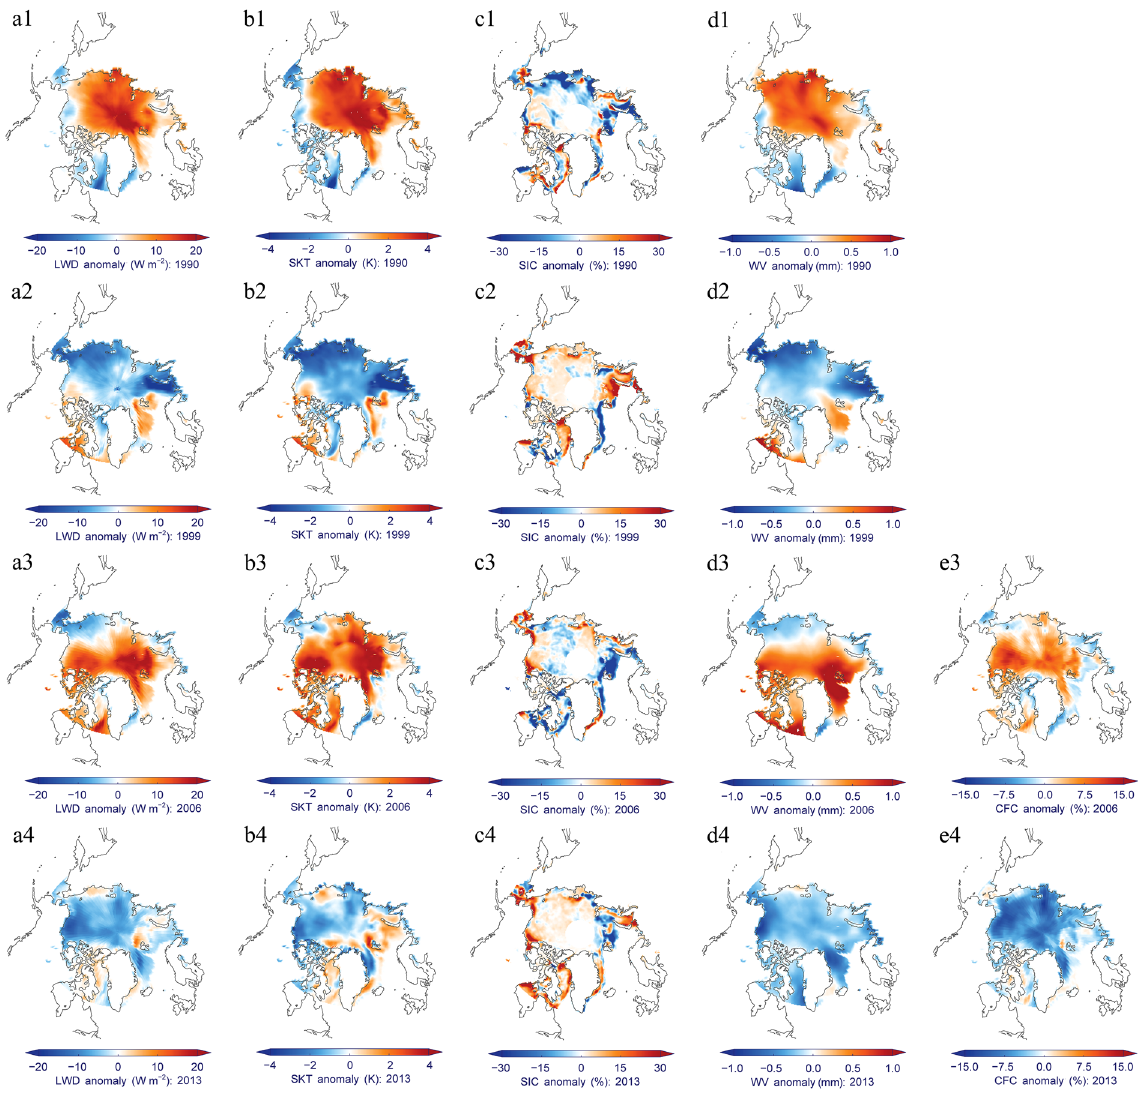
Figure 3. Spatial patterns in de-trended anomalies of all five variables for four representative years. Anomalies in surface ( a1–a4 ) LWD, ( b1–d4 ) SKT, ( c1–c4 ) initial SIC, ( d1–d4 ) WV and ( e3–e4 ) CFC in 1990, 1999, 2006 and 2013, respectively. This figure has been created with IDL8.3 (Exelis Visual Information Solutions, Boulder, Colorado) and the open source Coyote Library developed by David Fanning (https://github.com/idl-coyote/